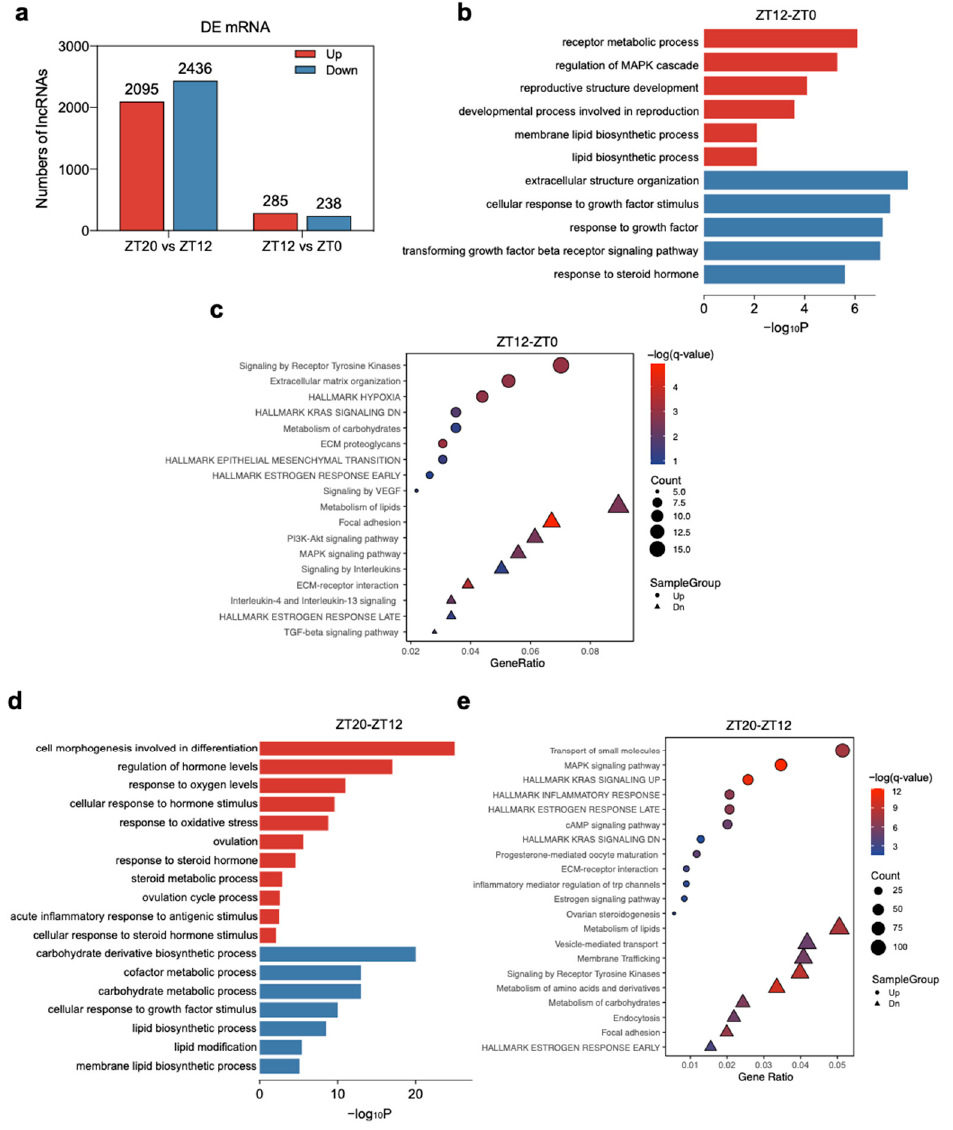
Figure 3. Gene ontology (GO) and pathway analysis of differentially expressed genes (DEGs) during follicle development in the chicken ovulatory cycle. ( a ) Number of DEGs in pairwise stages. ( b ) Enriched GO terms (top) and ( c ) pathways (bottom) of DEGs in ZT12 vs. ZT0 group. ( d ) Enriched GO terms (left) and ( e ) pathways (right) of DEGs in ZT12 vs. ZT0 group. Directly up-regulated (red) and down-regulated (blue) gene numbers and ontologies are shown.